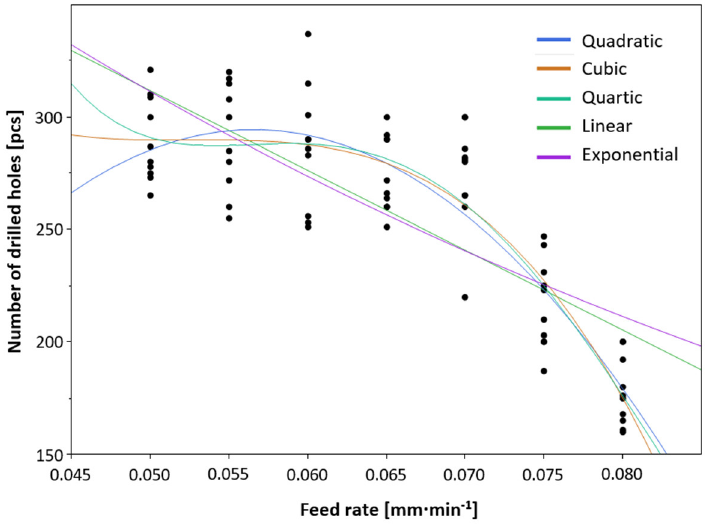
Figure 18. Plotted representation of individual models for examining the dependence of the number of holes drilled up to the moment of tool damage on the feed rate. Table 9. Basic parameters of the quadratic model of the dependence of the number of drilled holes up to the moment of tool damage on the feed rate.